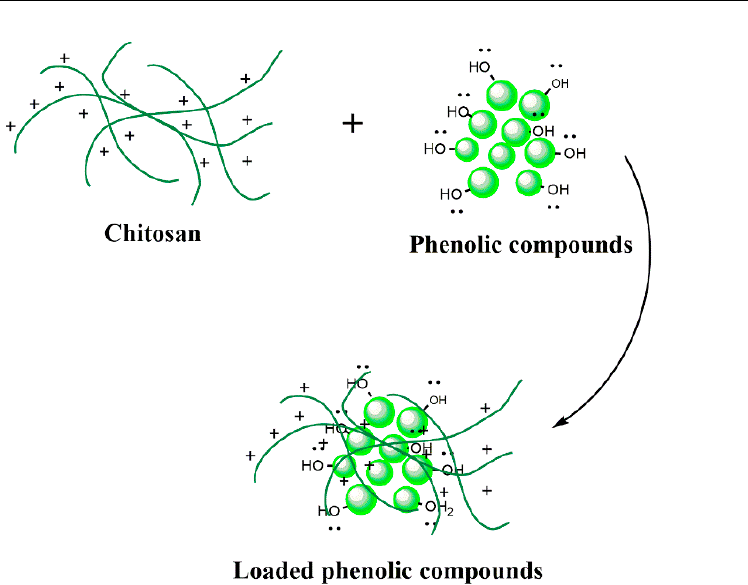
Figure 7. Scheme of the possible interaction between CS and the polyphenolic compounds. To determine if these matrixes protected the phenolic compounds, the stability of these systems before and after loading was determined by zeta potential (Figure 8a) and particle size (Figure 8b) in measurements for about 15 days. From these experiments, the most stable system resulted to be the CS matrix, whilst the particle size of the CS- b -PPEGMA blocks increased with the time, although the latter presented good size stability for up to 5 days. On the other hand, the study of zeta potential for the two different systems and the unencapsulated polyphenols can be observed, and it was found that the zeta